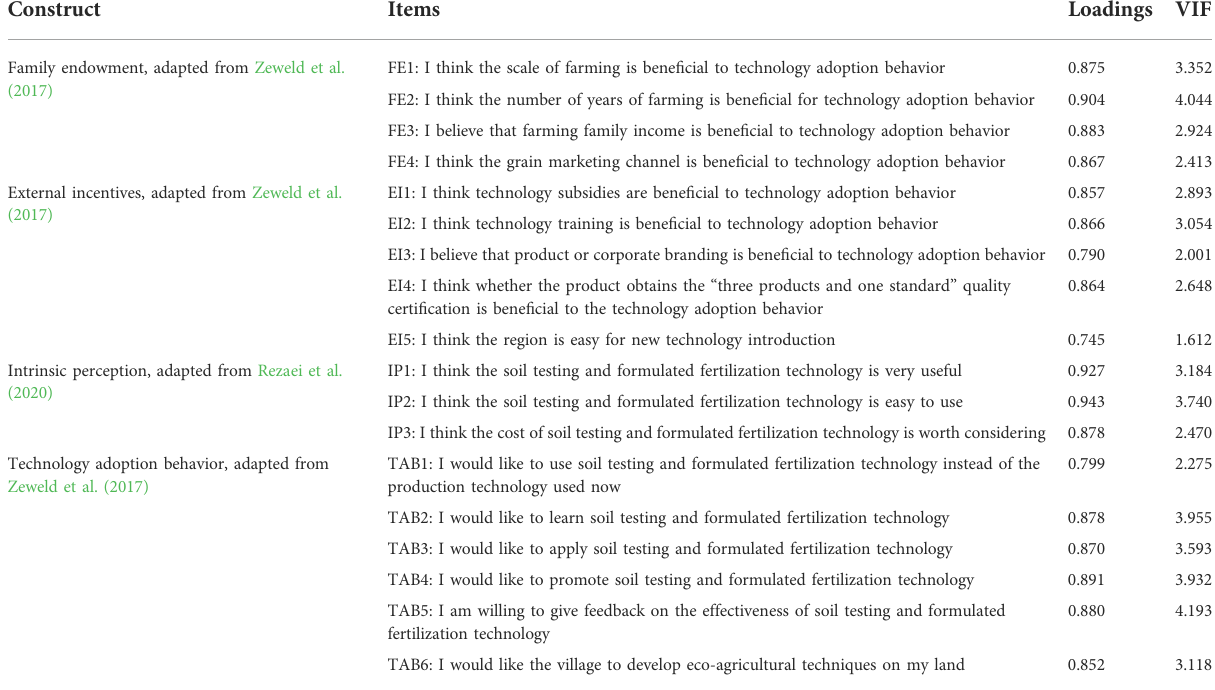
TABLE 1 Items used to measure each survey construct and